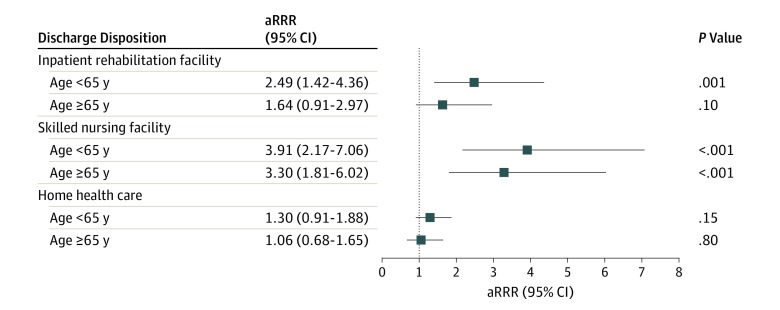
Association of African American Race/Ethnicity With Discharge Destination After Total Knee Arthroplasty Adjusted relative risk ratios (aRRRs) were calculated with white patients as the reference category and adjusted for age, gender, insurance type, comorbidities, metropolitan area location, hospital annual total knee arthroplasty volume, and comorbidities (except peptic ulcer disease, and solid tumor without metastasis in patients aged <65 years and prosthetic device complication, liver disease, metastatic cancer, solid tumor without metastasis, and unhealthy alcohol use in patients aged ≥65years because these variables had P values >.10). Squares indicate point estimates; bars, 95% CI.